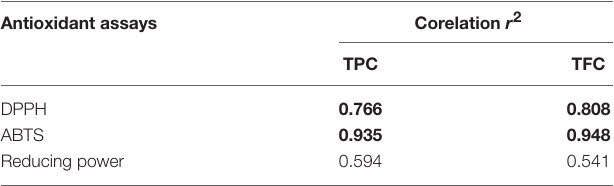
TABLE 2 | Correlation coefficient r 2 between antioxidant assays (DPPH, ABTS, and reducing power) and total phenolic content (TPC) and Total flavonoid content of selected medicinal